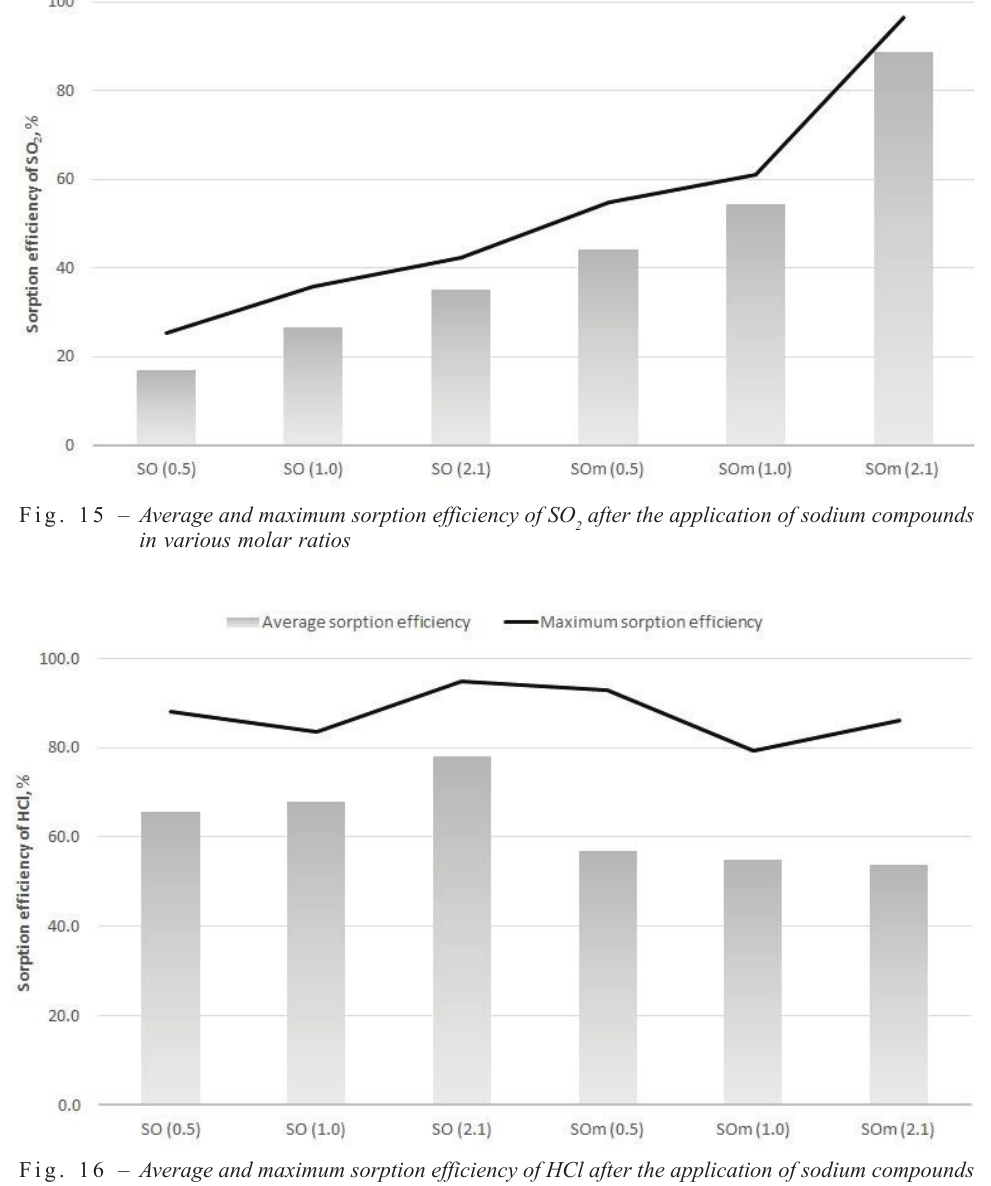
Fig. 16 – Average and maximum sorption efficiency of HCl after the application of sodium compounds in various molar ratios